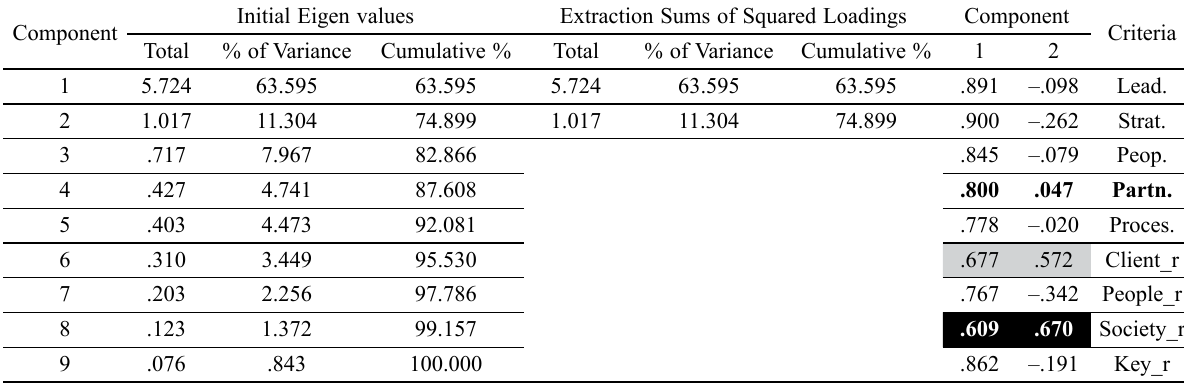
Table 8. Factor analysis of all the criteria Component